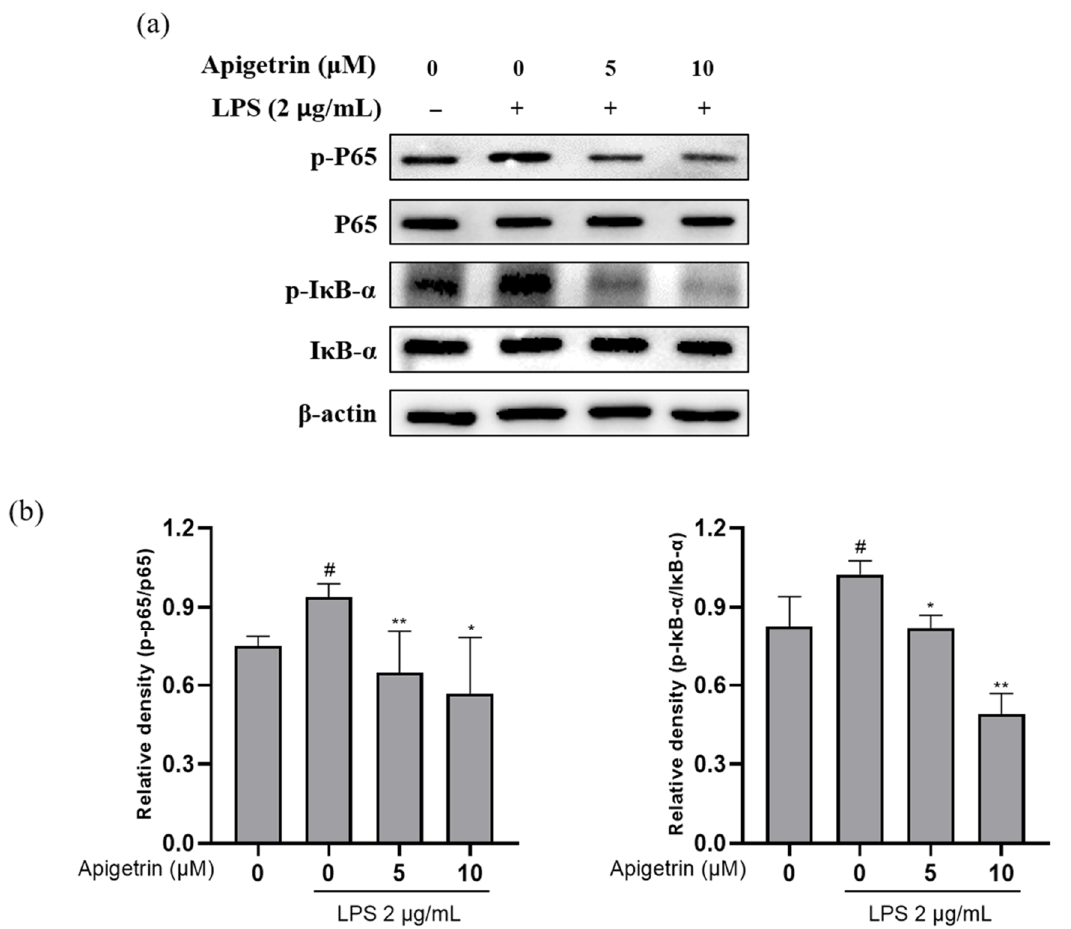
Figure 4. ( a ) Inhibitory effect of apigetrin on the LPS-induced protein expression of NF- κ B signaling in L6 cells. L6 cells were treated with apigetrin (0, 5, and 10 µ M), with or without LPS (2 µ g/mL), for 24 h. Protein expression was determined by Western blotting. ( b ) The results are presented as the mean ± standard deviation (SD) of three independent experiments. # p < 0.05 vs. untreated group; * p < 0.05 vs. LPS-alone-treated group; ** p < 0.01 vs. LPS-alone-treated group.